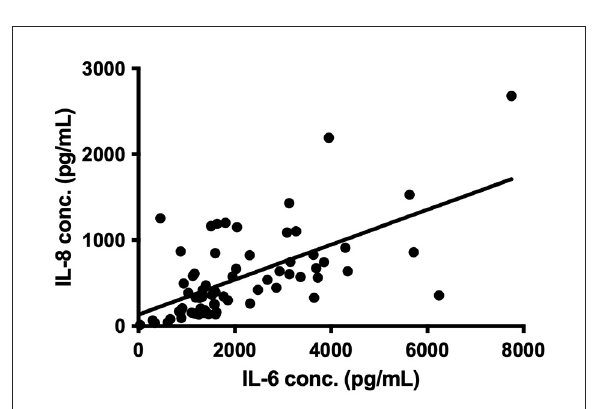
FIGURE2 Correlation between IL-6 and IL-8 concentration (conc.) in 67 CSDH fluid samples, R = 0.615, p < 0.0001 on Spearman correlation, line represents linear regression (R 2 = 0.381).